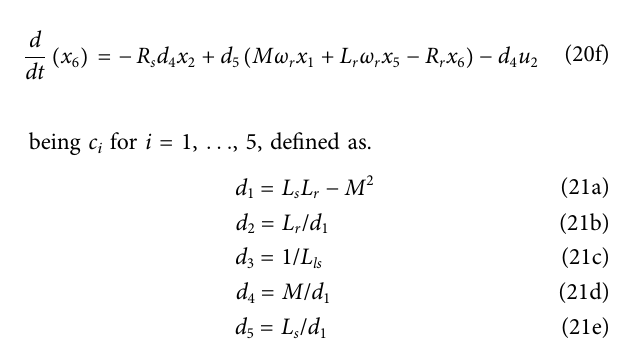
FIGURE 6 | Projections of the voltage vectors in the α − β (left) and x − y (right) planes for an asymmetrical six-phase IM with isolated neutrals. The number that de fi nes each voltage is identi fi ed by two octal numbers corresponding to the binary numbers [ S a S b S c ] and [ S d S e S f ] .